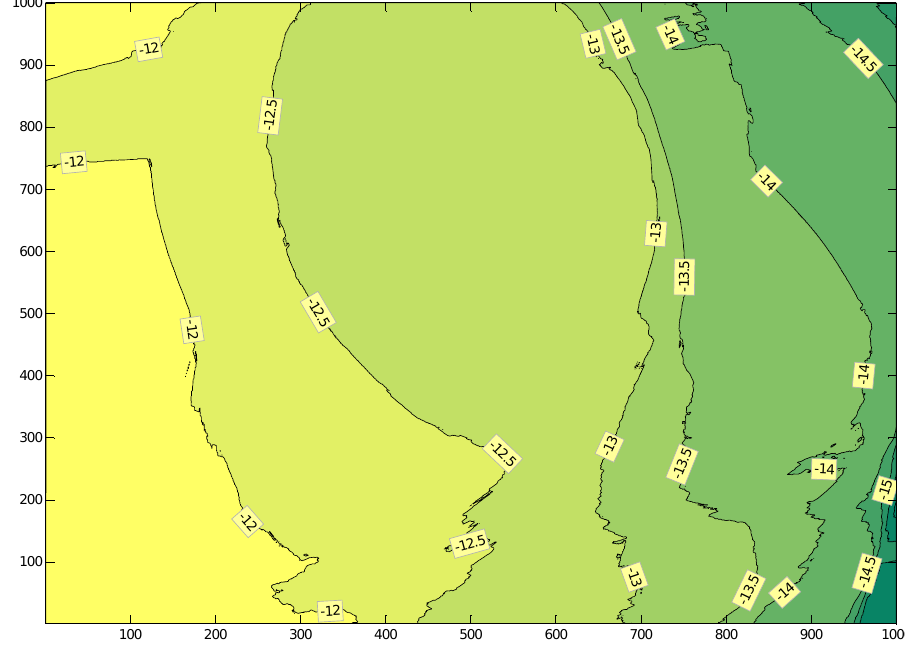
Figure 2. Elevation correction layer corresponding to an area of about 30 km × 30 km. The values on the X and Y axis represent the pixel coordinates.